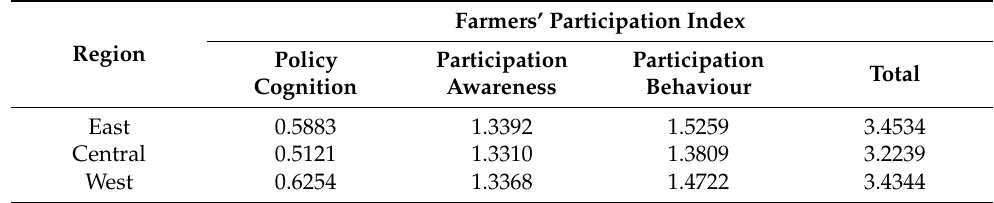
Table 7. Farmers’ participation index in rural settlement environment improvement by region.